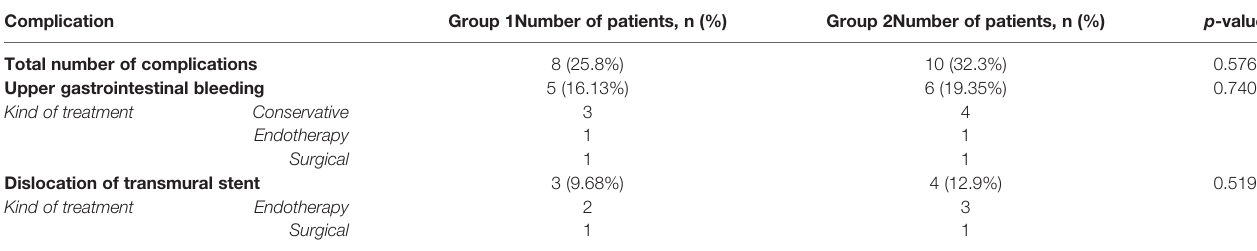
TABLE 4 | Complications of endoscopic treatment of patients with PPPFCs.